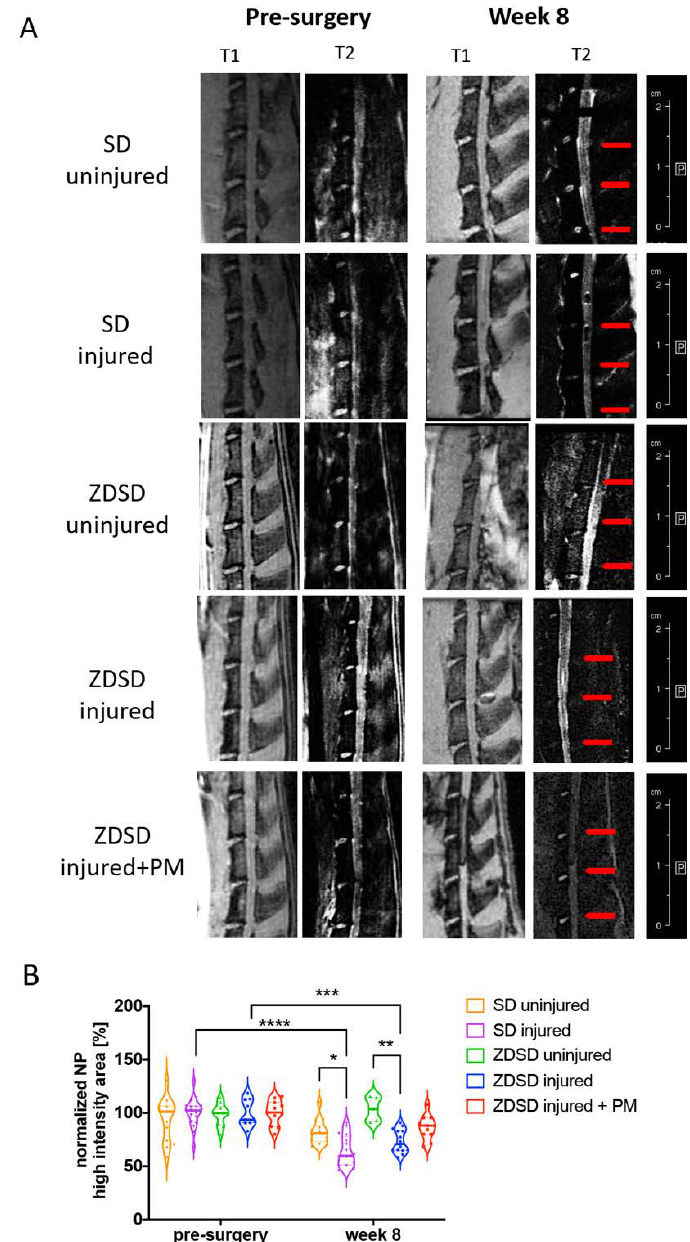
Figure 2. PM attenuates NP dehydration in needle-injured IVDs. ( A ) Representative images of IVD degeneration at week 8 vs. pre-surgery. Left: (T1) scans (TR: 50 ms, TE: 1.7 ms), right: T2-weighted scans (TR: 5000 ms, TE: 30 ms), obtained using Bruker BioSpec 9.4 T (94 / 20) with Avance III electronics 9.4 T. Red arrows indicate needle-injured IVDs. ( B ) Quantitative analysis of the µ MRI images showing relative NP high-intensity areas (T2) in discs in the various SD and ZDSD rat groups pre-surgery and at 8 weeks post-surgery. µ MRI data were normalized to mean uninjured discs at the same level from rats undergoing sham surgery. * p < 0.05, ** p < 0.01, *** p < 0.001, **** p < 0.0001, n ≥